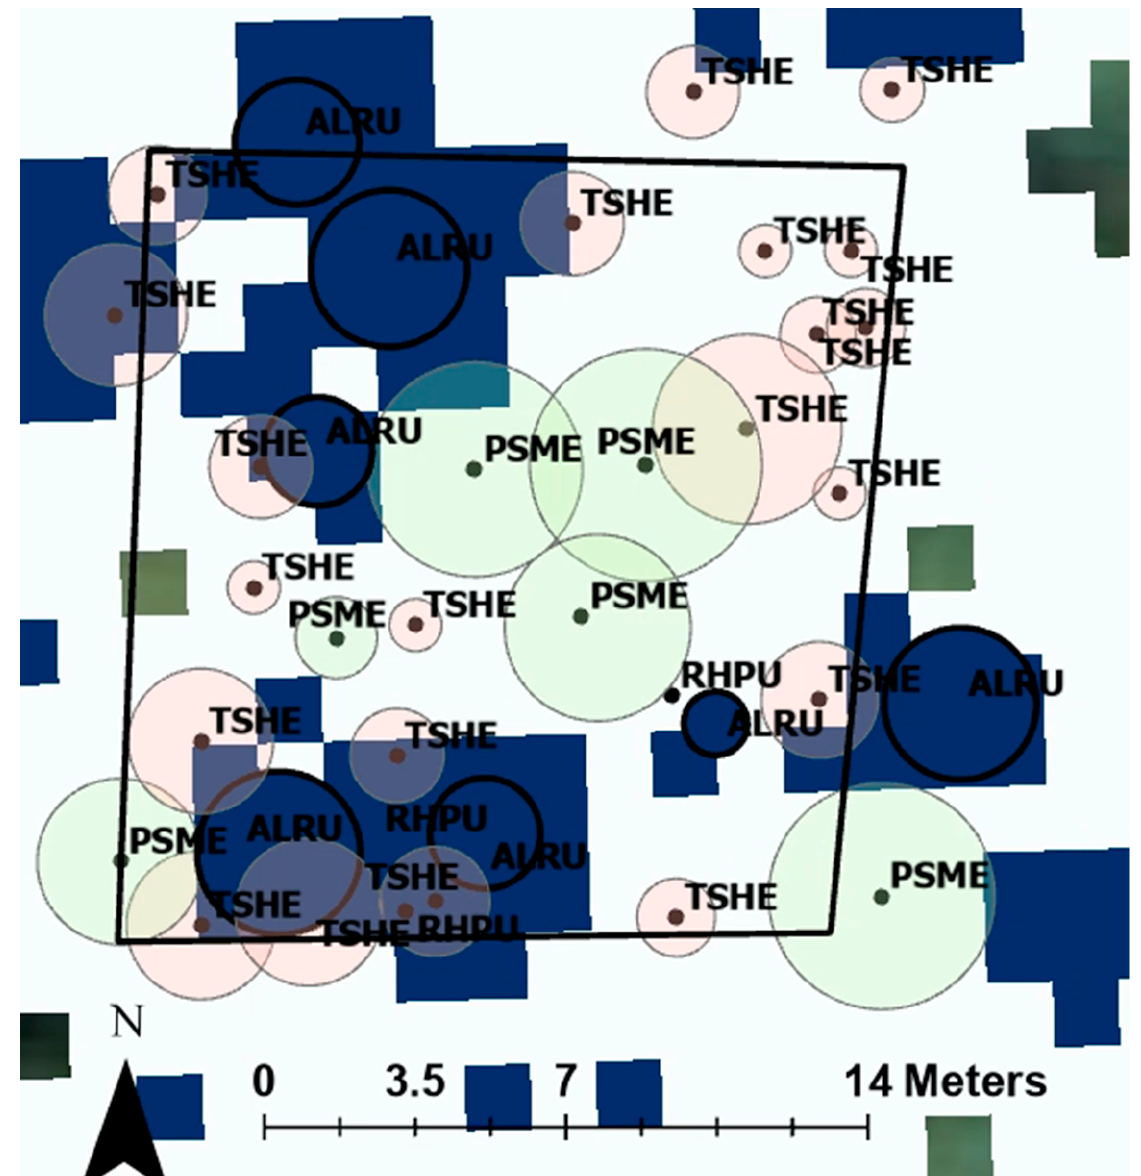
Figure 7. Red alder classification raster with example tree plot laid over top. The dark blue pixels on the raster were identified by the classification model as red alder, and the white pixels were identified as not red alder. Dark green pixels were identified as non-forest. Circles are colored based on the corresponding species of the tree points. Red alder (ALRU) is blue, Douglas fir (PSME) is transparent light green, and western hemlock (TSHE) is transparent pink.